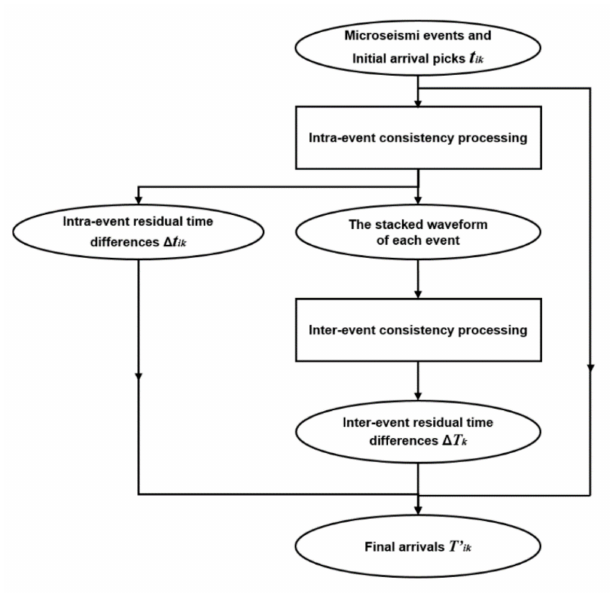
Figure 4. Flowchart of the proposed global optimization